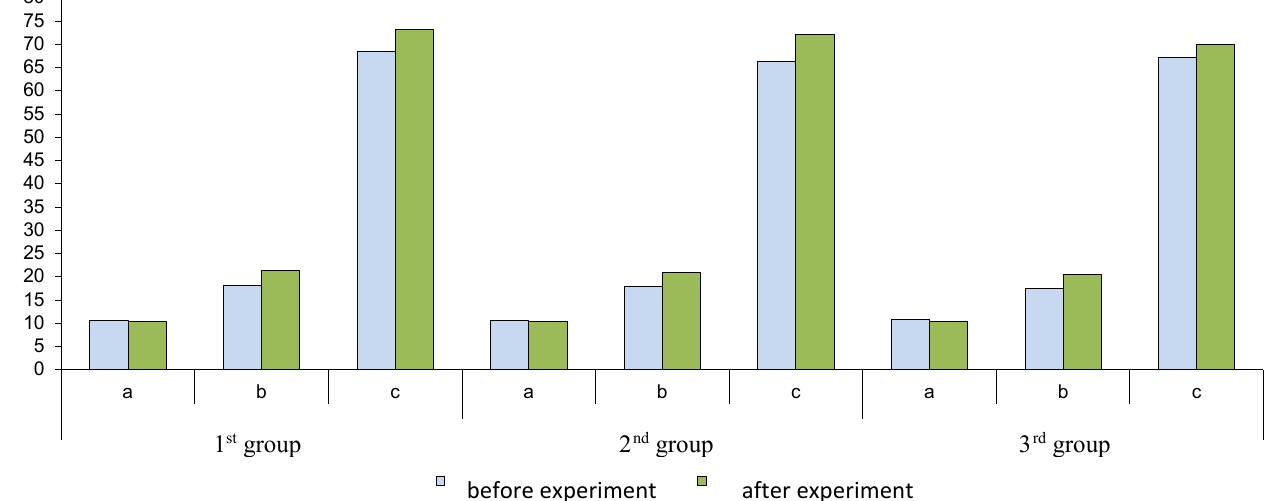
Fig 1. Indicators of quickness level in experimental groups before and after experiment: